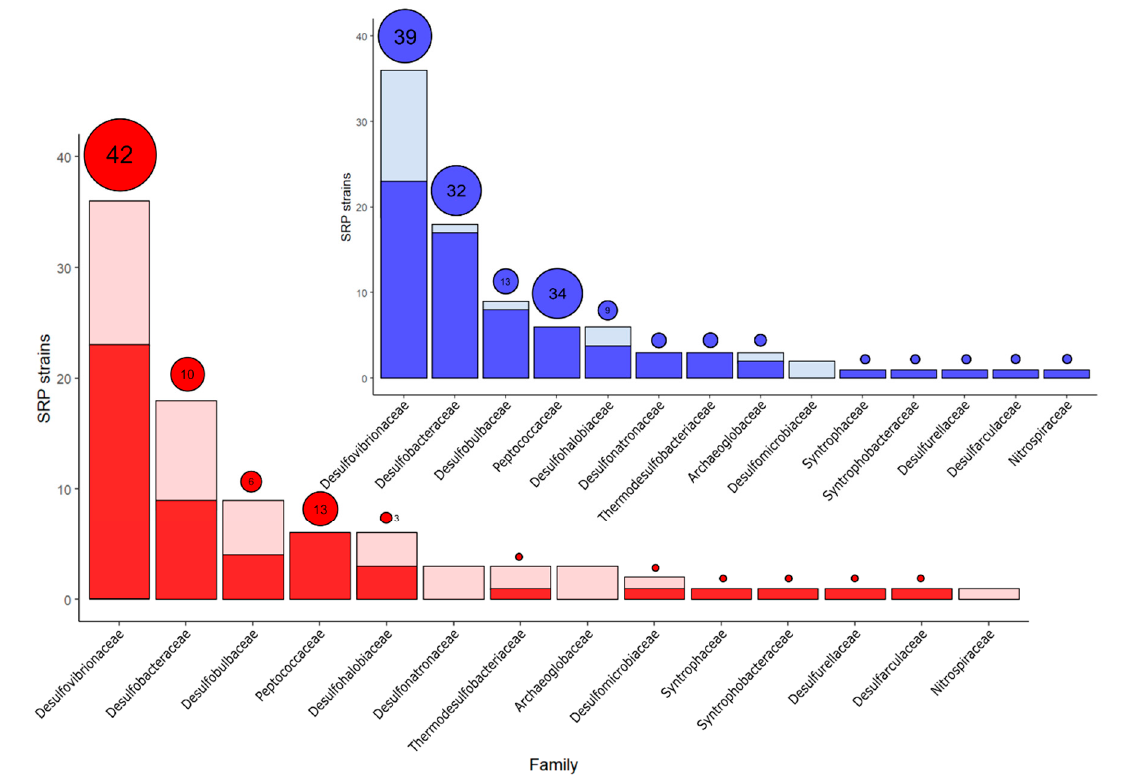
Figure 2. Distribution of SRP carrying prophages and CRISPR across different families. On the bottom chart, red and light red represent lysogenic and no lysogenic SRPs, respectively. Red circles represent the total number of prophages found in each family. On the top chart, blue and light blue represent CRISPR-containing and non CRISPR-containing SRP, respectively. Blue circles represent the total number of CRISPR arrays found in each family.